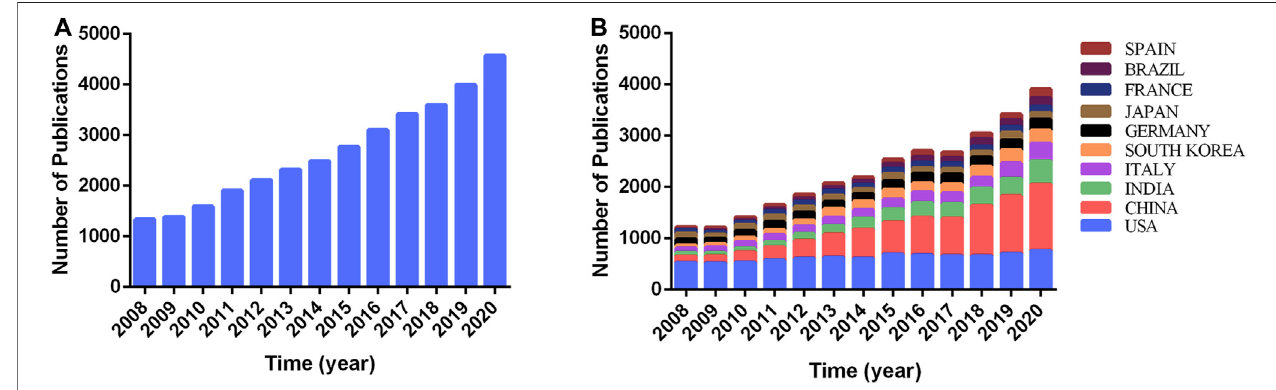
FIGURE 1 | Trends in the number of publications of country/regions in natural products in cancer research. (A) The annual worldwide publication output. (B) The annual national publication output of the 10 most productive countries/regions.